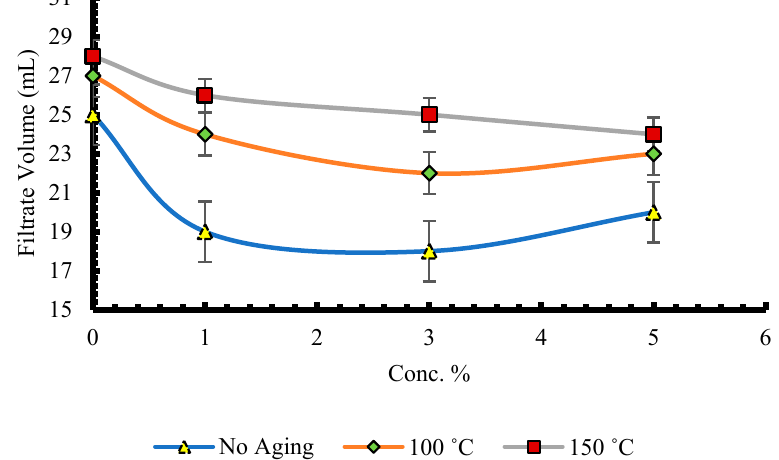
Figure 3. Filtrate volume of AA:Gly NADES-based mud.